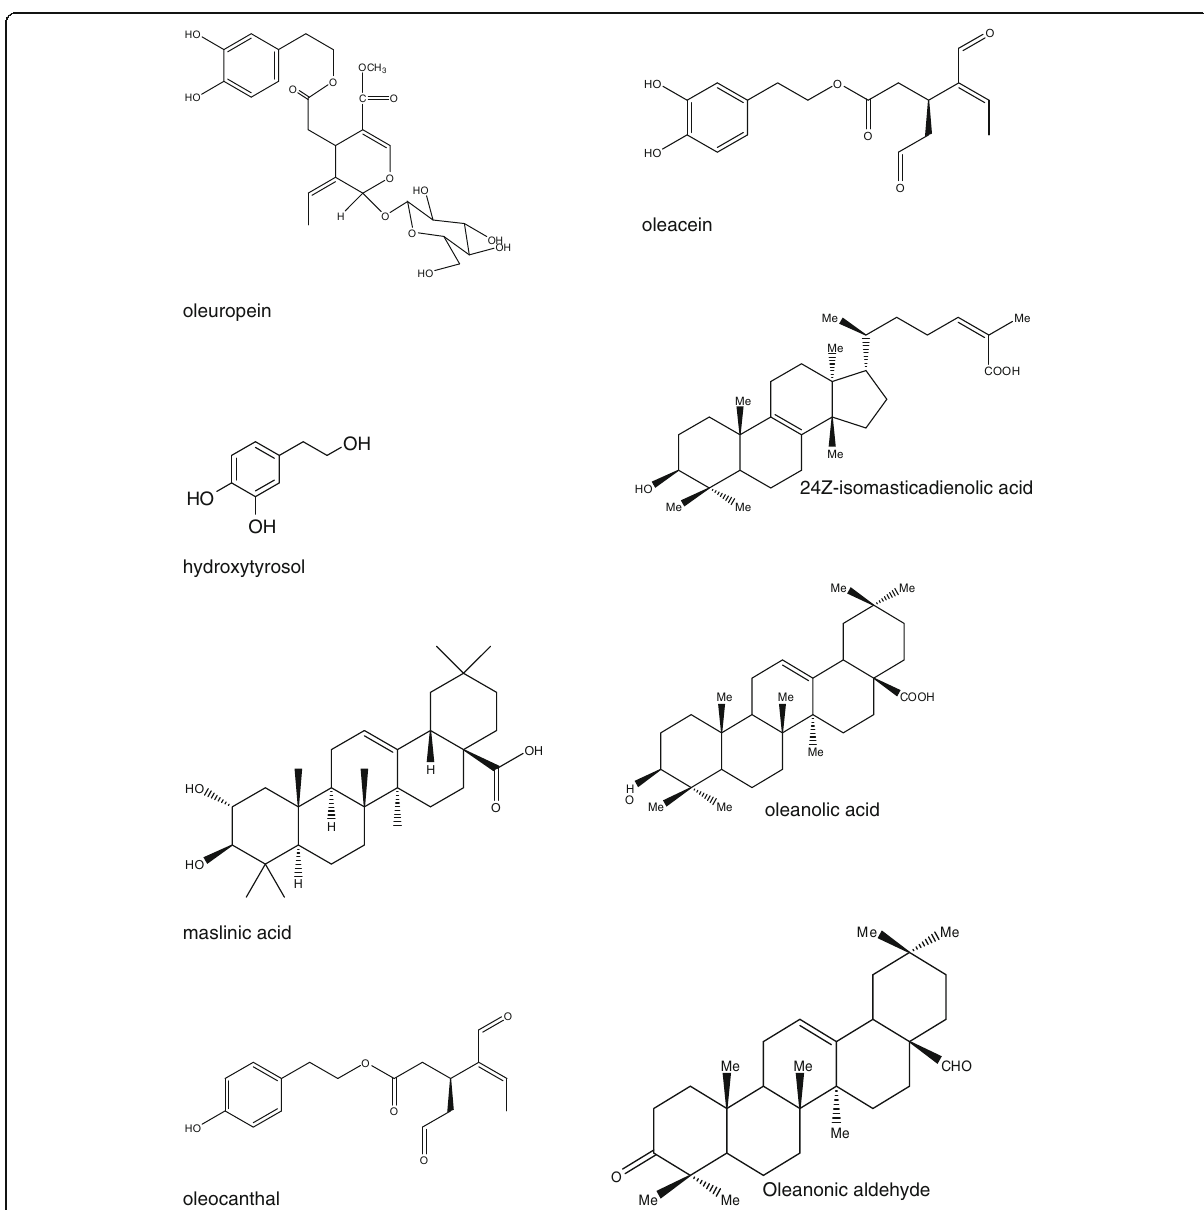
Fig. 1 Chemical structures of the tested compounds from Olea europaea (oleuropein, maslinic acid, hydroxytyrosol, oleocanthal, oleacein) and Pistacia lentiscus (24Z-isomasticadienolic acid, oleanolic acid, oleanonic